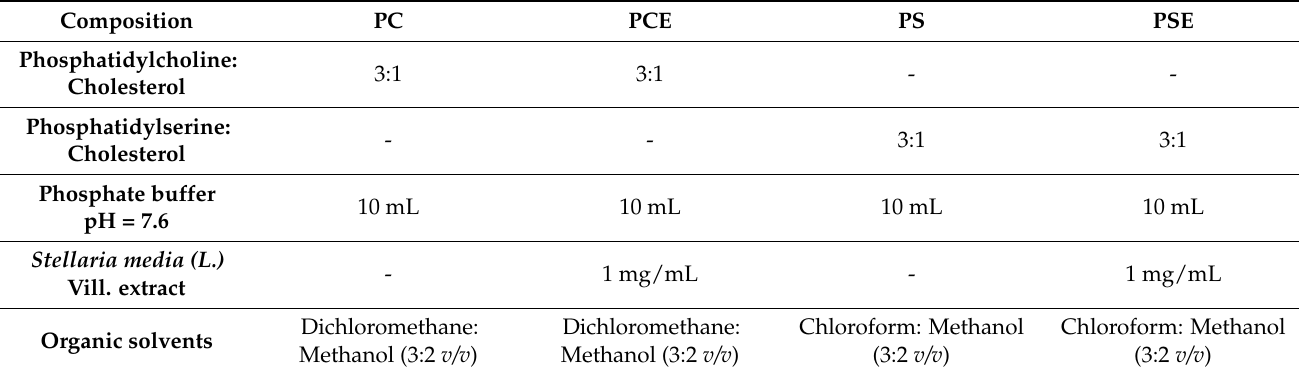
Table 1. Composition formula related to liposomes with and without Stellaria media (L.) Vill.